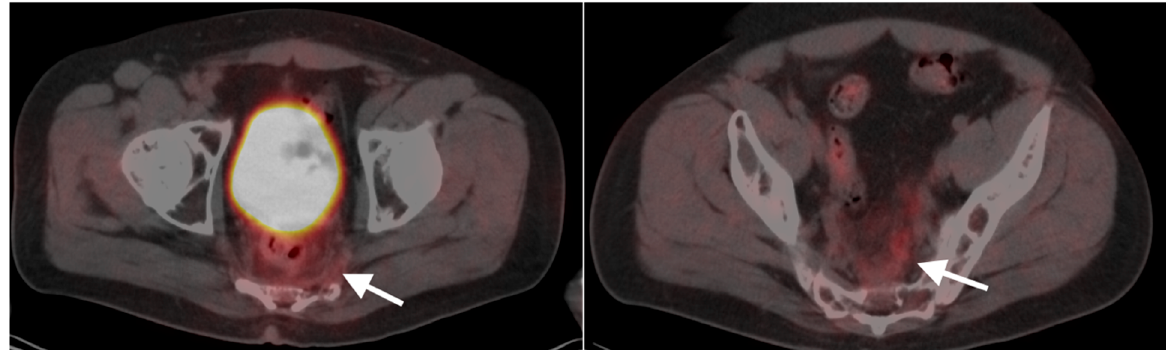
Figure 37. Post-radiation inflammatory change. Axial fused FDG PET-CT images of the pelvis. Presacral thickening/stranding (white arrows) that is metabolically active is due to inflammation secondary to radiation. These findings can persist for up to 2 months or more.